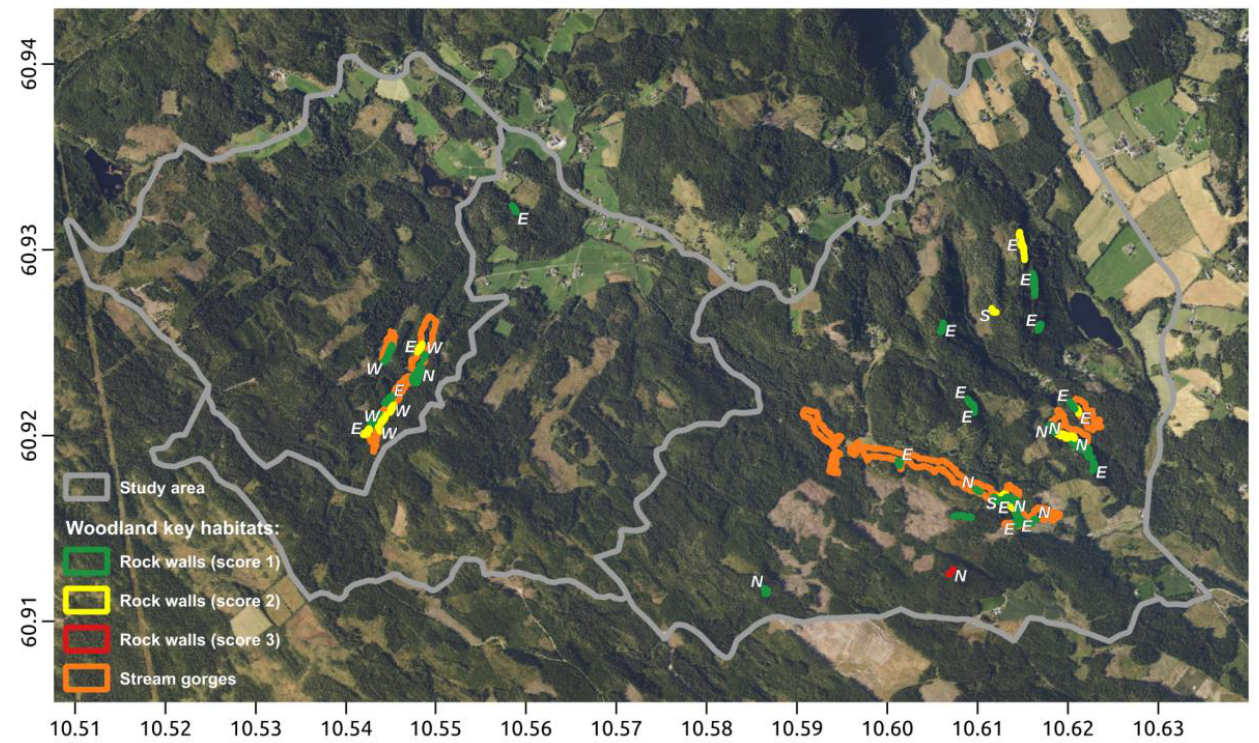
Figure 5. Pre-information map of potential rock walls and stream gorges in the extended study area. Letters refer to aspect; N = north, E = east, S = south, and W = west.